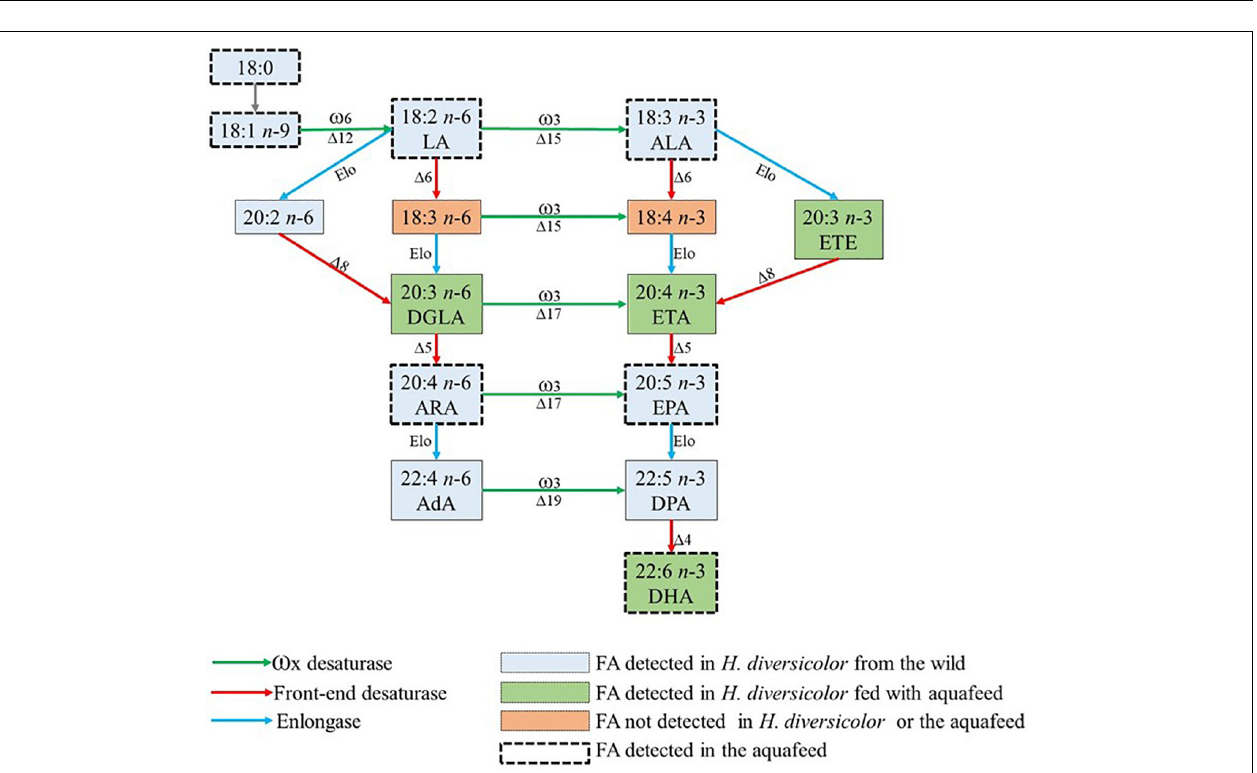
FIGURE 6 | Hediste diversicolor at the beginning of the experiment (A) and after being fed on a commercial aquafeed for 40 days under different combinations of water temperature (20 and 25 ◦ C) and salinity (15, 20, and 25) (B) .